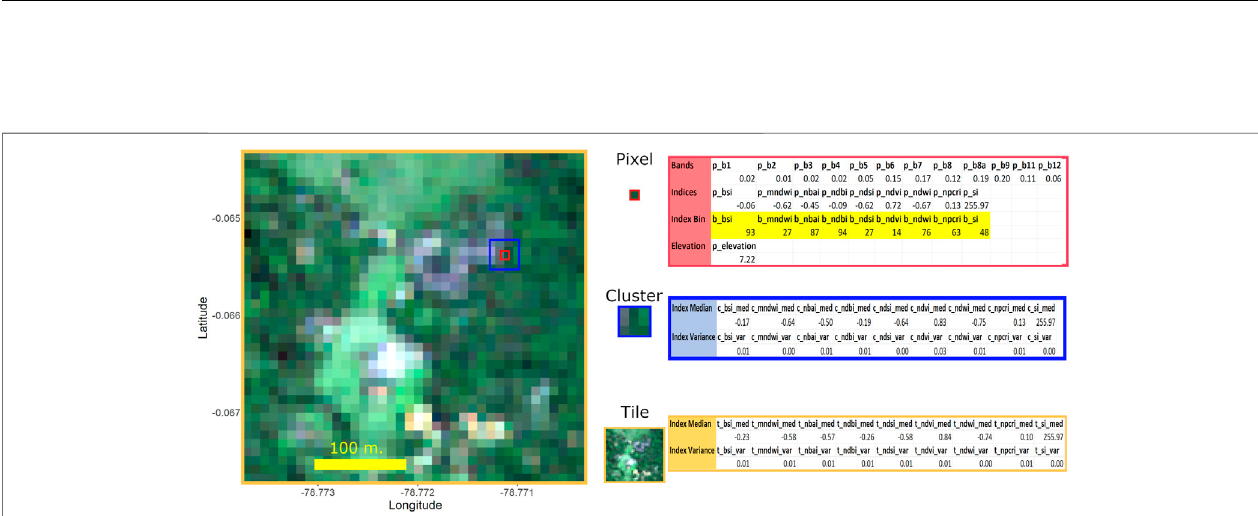
Frontiers in Environmental Science |